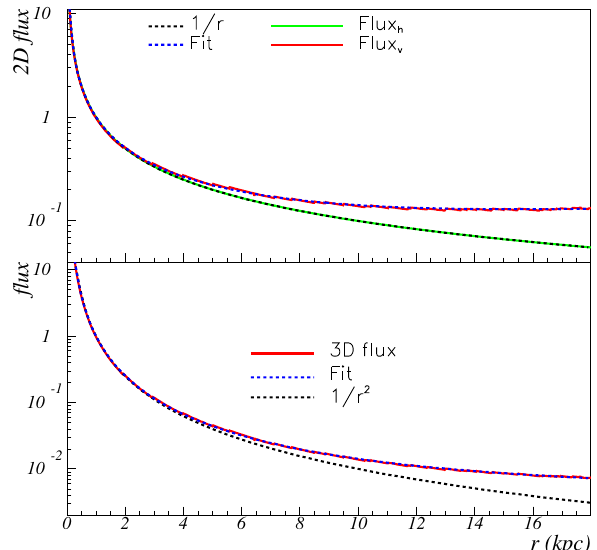
Fig. 4 Top: two-dimensional fluxes vs. radial distance r . Green line: horizontalflux F h ( r ) .Redline:verticalflux F v ( r ) .Themodeledgalaxy has a total mass M ∗ tot = 3 × 10 11 M (cid:12) , a radial scale length h R = 1 . 5 kpc (deprojectioncorrectionsareincluded),andascaleheight h z = 0 . 03 h R . The dashed black line is a 1 / r curve to guide the eye. The dotted blue line shows the fit F v = 1 / r + 0 . 0042 r , for r in kpc. Bottom: total flux F ( r ) (red line) with fit F = 1 / r 2 + 0 . 0042 for r in kpc (dotted blue line). The dashed black line is the Newtonian 1 / r 2